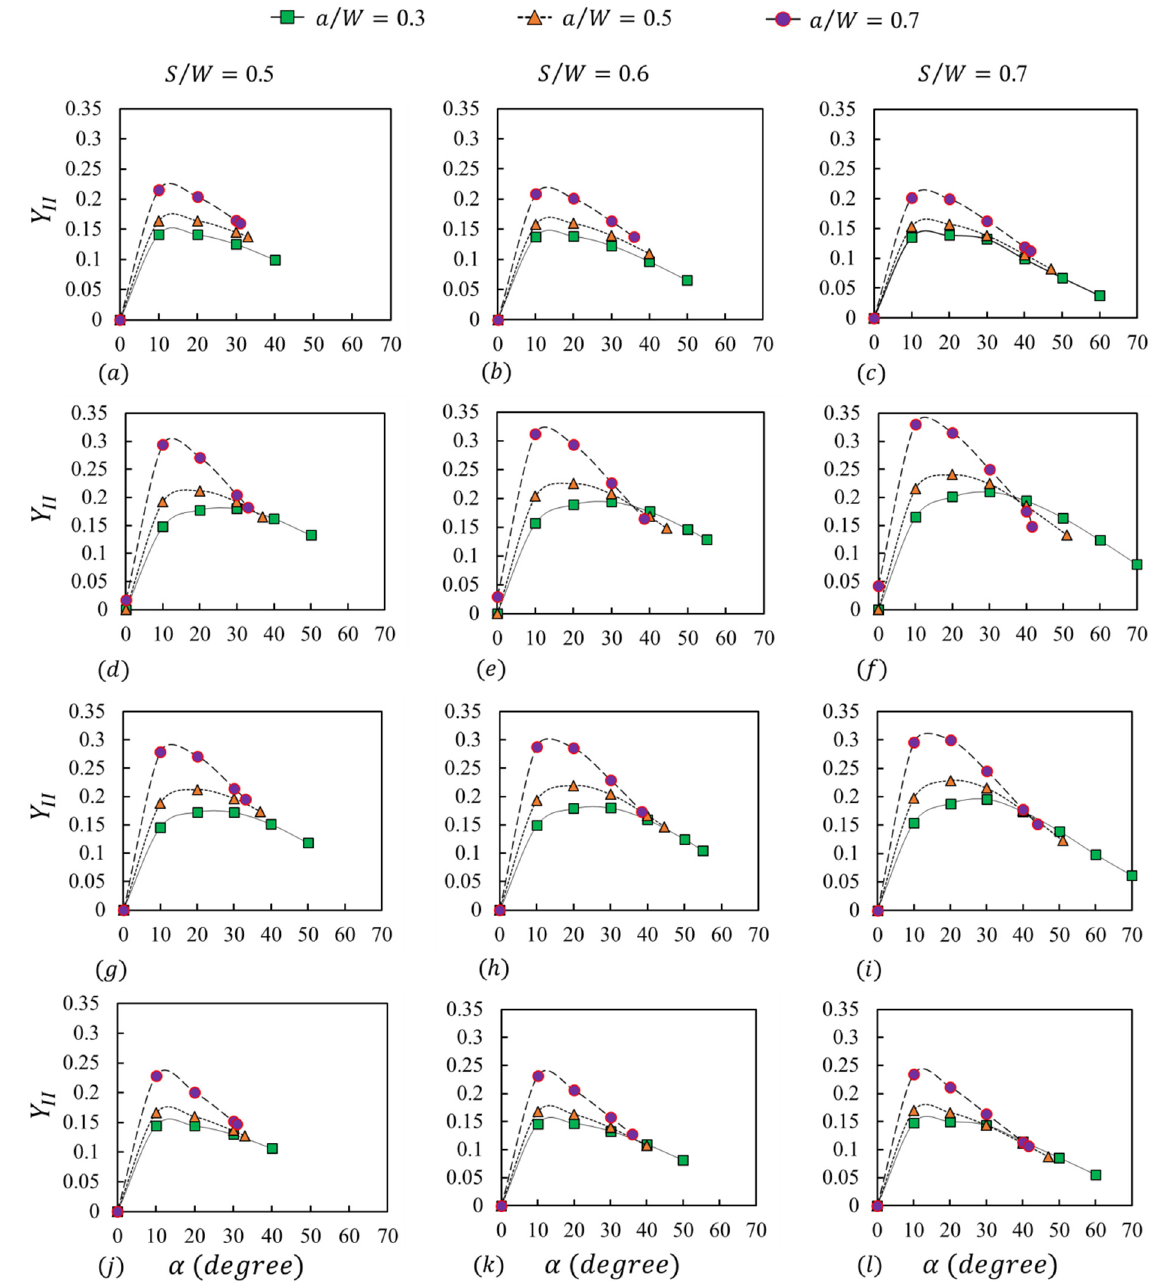
Figure 5. Variations of mode II geometry factor (Y II ) with crack inclination angle ( α ) for different BISBB specimens and different geometrical and loading conditions. ( a – c ) Al-Adhesive-Alumina, ( d – f ) Alumina-Adhesive-Al, ( g – i ) Al-Adhesive- Al, ( j – l ) Alumina-Adhesive-Alumina.